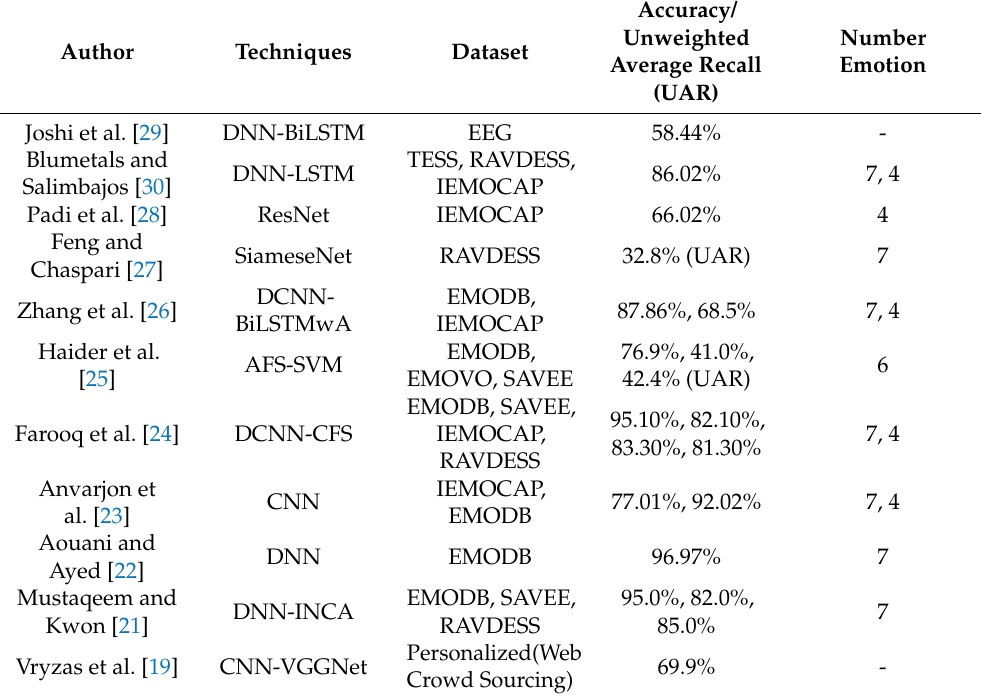
Table 2. Summary of Related